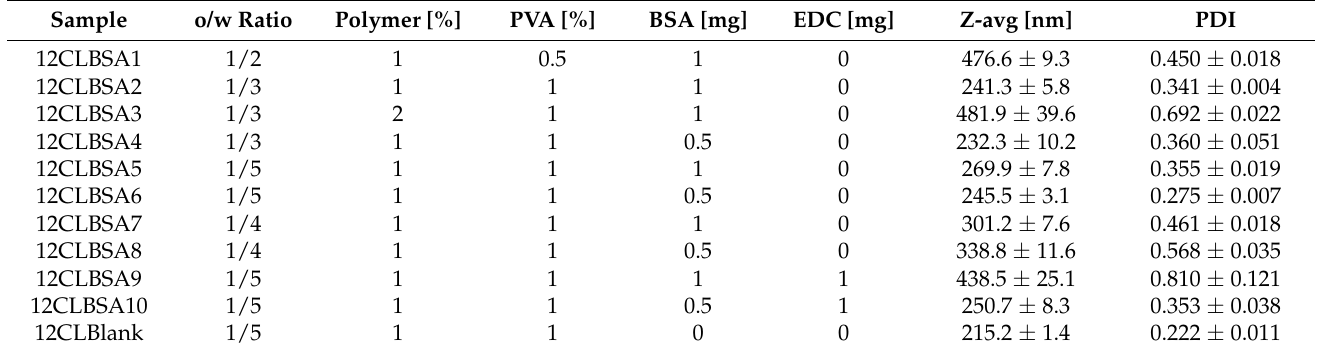
Table 1. Optimisation of the nanoparticle preparation method by BSA